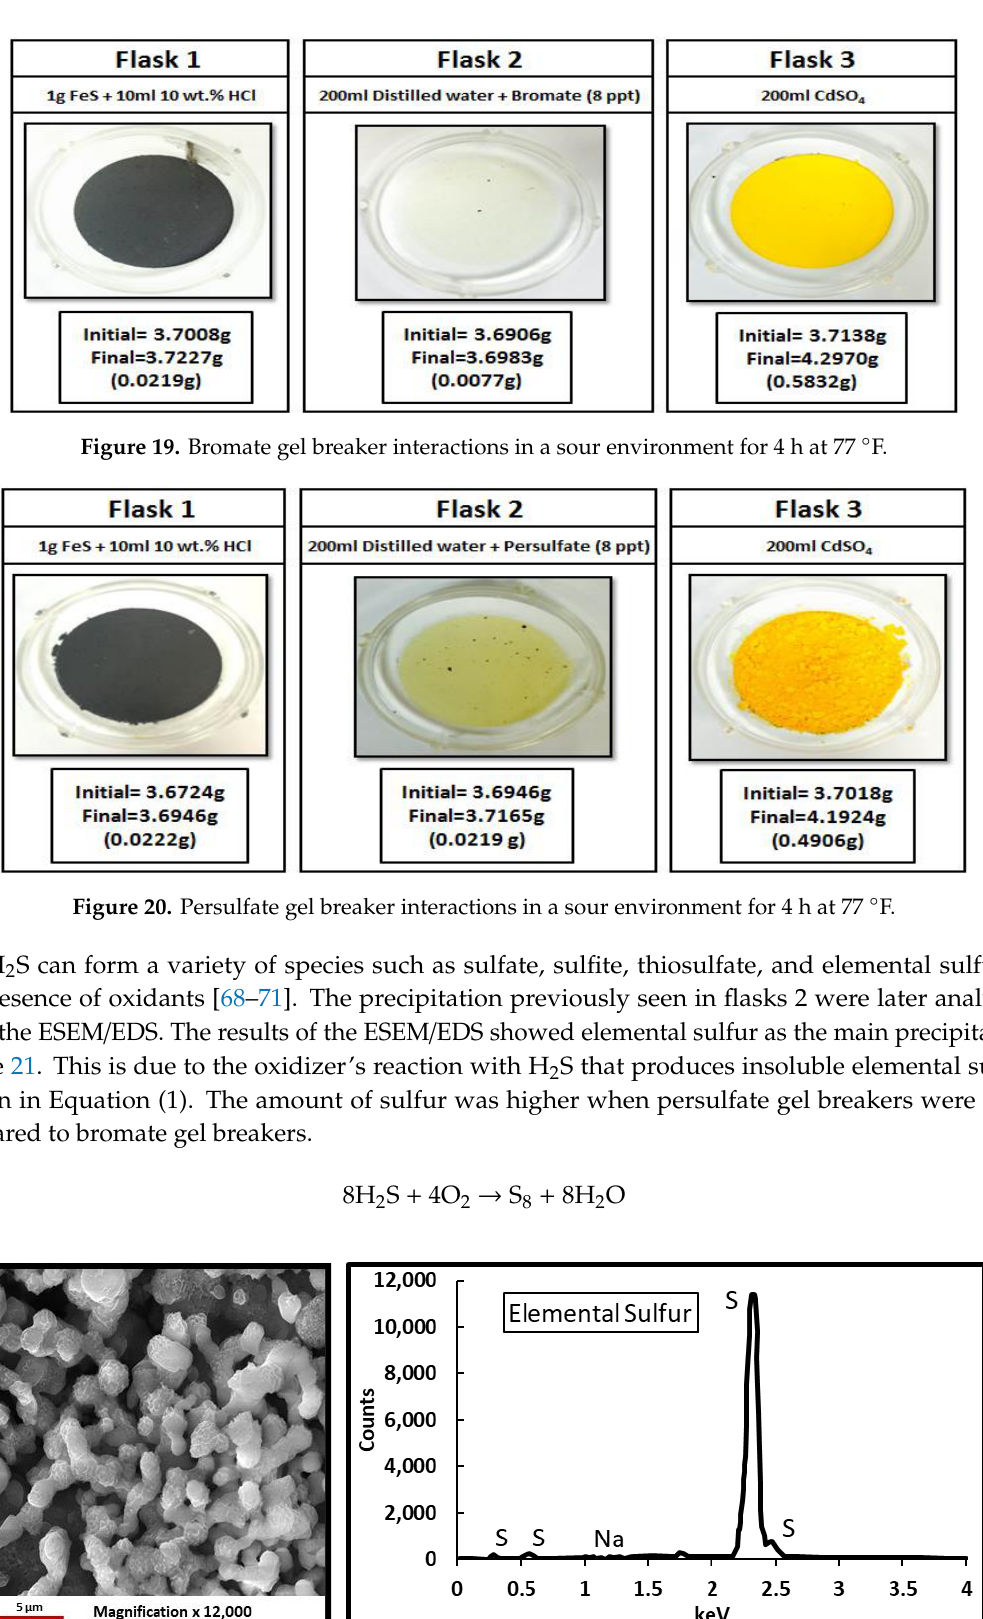
Figure 18. Acid gel breaker interactions in a sour environment for 4 h at 77 °F.